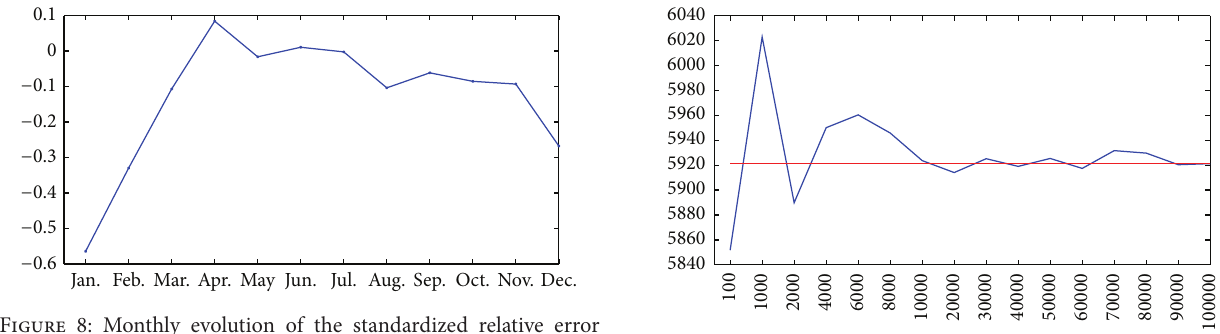
Figure 9: Monte Carlo simulations convergence trend of the HDD call price of